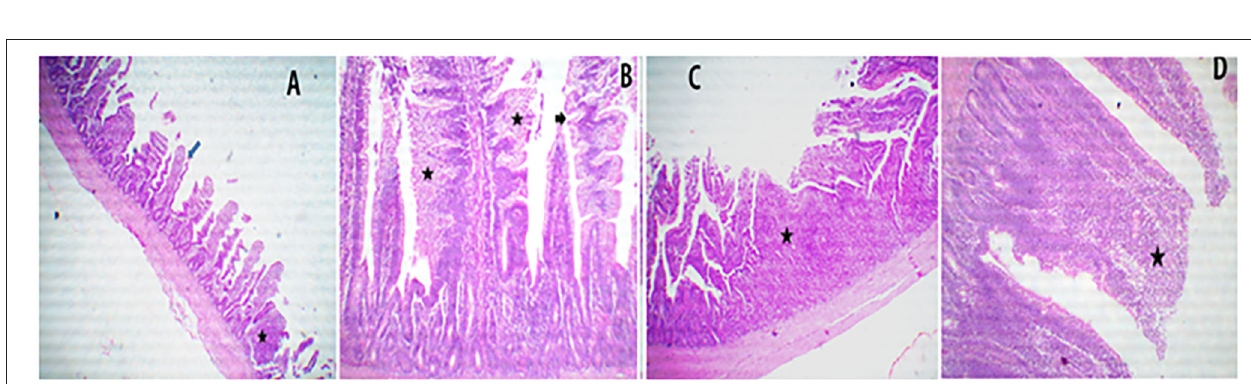
FIGURE 3 | A representative photomicrograph of 40 × magnification H&E stained small intestine sections of the broiler chickens. The sections from the jejunal segments of PROE0 group showed free lumen with nearly normal villus structures (A) , the sections from the jejunal segments of PROE1 group showed free lumen, a few denuded villi tips with increase intestinal crypt layer depth (towheads arrow) besides partial fusion (arrow) (B) , and the jejunal segments from PROE2 group showed separate tall villi and marked serrated surfaces (arrows) with goblet cell metaplasia (star) beside partial fusion some villus (C) . In addition to, increased intestinal glands layer besides partial destructed villi with some fusion’s villi (star) were observed in PROE3 group (D) .